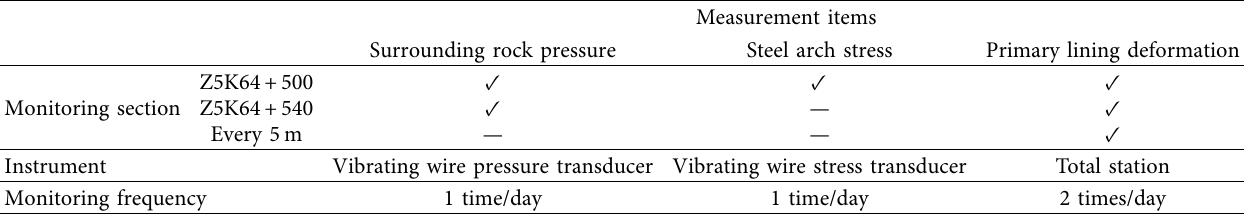
Table 2: Measurement items for mechanical characteristics of the primary lining.